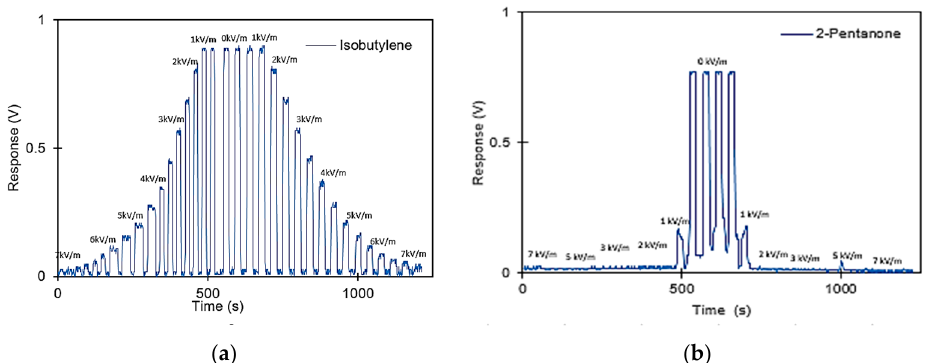
Figure 5. Composition electrode response with varying voltage in steps of 500 kV/m ( a ) isobutylene; ( b )